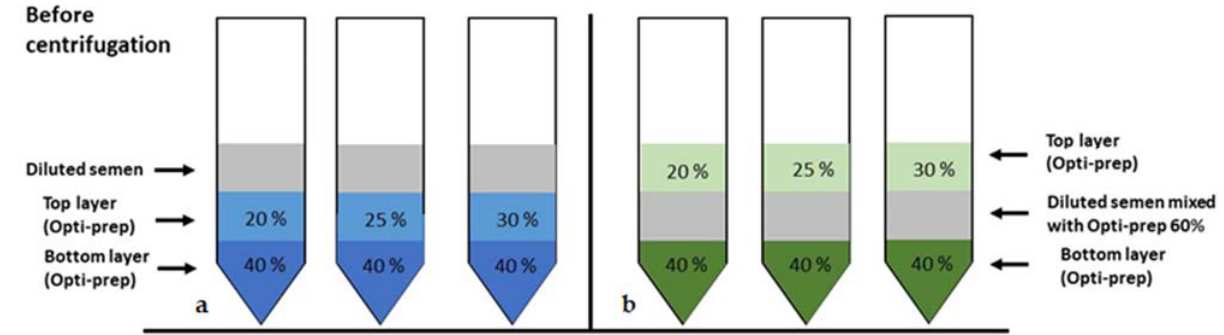
Figure 1. Graphical illustration of the density gradient centrifugation (DGC) techniques before centrifugation at 1000 × g for 20 min. ( a ) Modified sedimentation DGC technique before centrifugation. ( b ) Modified flotation DGC centrifugation technique before centrifugation.